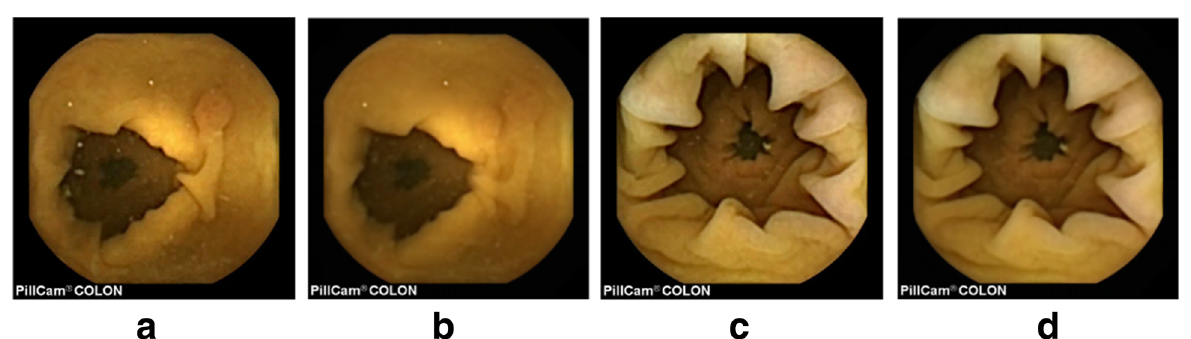
Fig. 2 Sample result for frame interpolation using neighboring frames on seq1 and seq4 with image size 576 × 576. Frame number 4 is interpolated using frame number 3 and 5. a Seq4 6 mm polyp original frame number 4 and b estimated frame using our method. c Seq1: Original input: frame